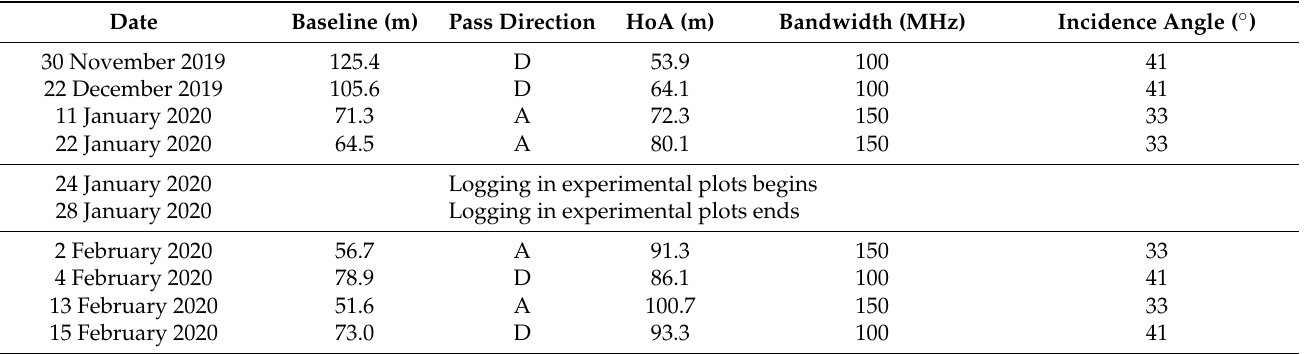
Table 1. TanDEM-X (TDX) acquisition dates and imaging parameters. The baselines given here are the effective perpendicular baselines. Pass directions are given as D (descending) or A (ascending). Incidence angles are relative to vertical at the centre of each scene. HoA = Height of